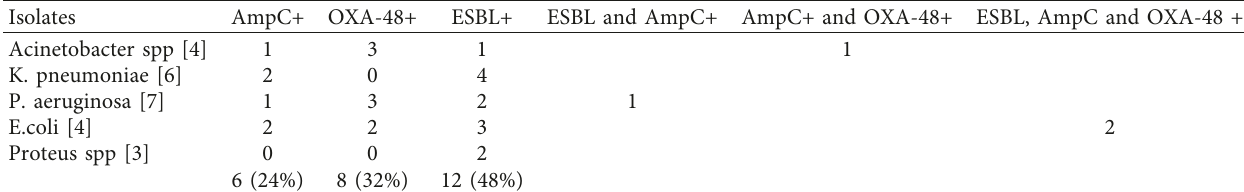
Table 6: Distributions of β -lactamases and carbapenemases in gram-negative bacteria isolated from patients with acute exacerbation of chronic obstructive pulmonary disease at JUMC, southwest Ethiopia,